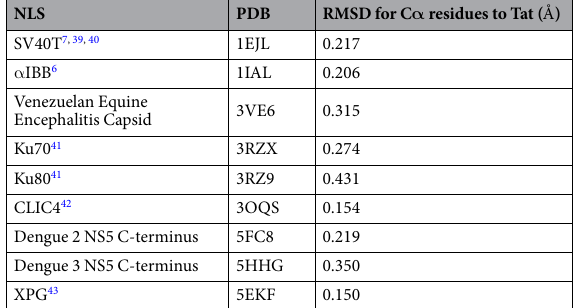
Binding affinity of the HIV-1 Tat:NLS/CPP in complex with importin- α . To estimate the bind- ing affinity, importin- α was serially titrated against equal concentrations of HIV-1 Tat:NLS/CPP, and binding captured using a GST-pulldown. The binding affinity was determined to be 1.2 ± 0.2 µ M from three replicates (Fig. 6). The binding affinity measured for HIV-1 Tat:NLS/CPP is in the low micromolar range and similar to previously reported values of other NLSs including Dengue 2 C-terminal NS5, 0.27 ± 0.1 µ M; and Dengue 3 C-terminal NS5 0.37 ± 0.11 µ M 32 .